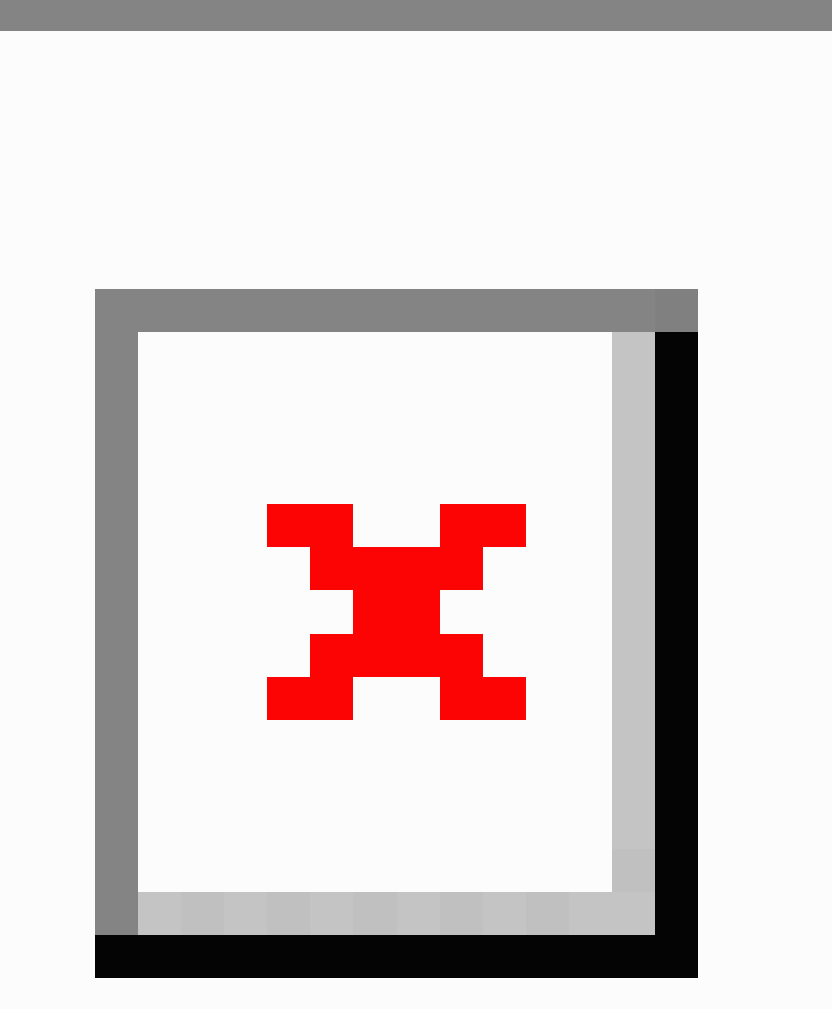
Figure 3. Food Tracker automatically triggers the smartphone’s camera, enabling photo capture of meals. Users can subjectively rate food portion (small, moderate, large), source (home-made, packaged, restaurant served), and healthiness (not so healthy, moderately healthy, very